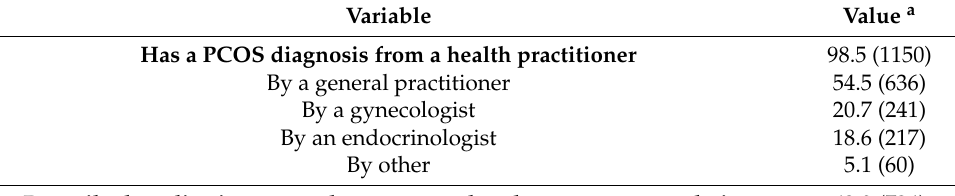
Table 2. Medical history of women with polycystic ovary